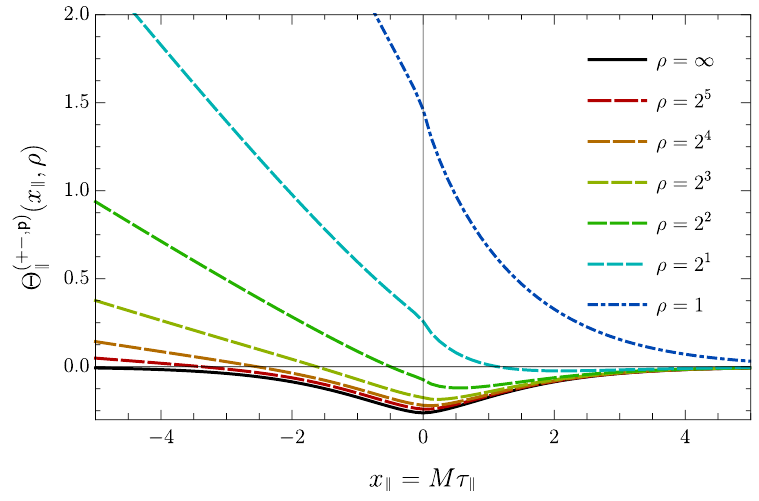
(+ − , p ) ( x , ρ ) of the free energy for different values of Figure 19: Scaling function Θ aspect ratios ρ ≥ 1. For growing ρ the influence of the domain wall shrinks, until it vanishes completely for ρ = ∞ , where the scaling functions approaches its limiting ( p ) ( x ) form Θ b